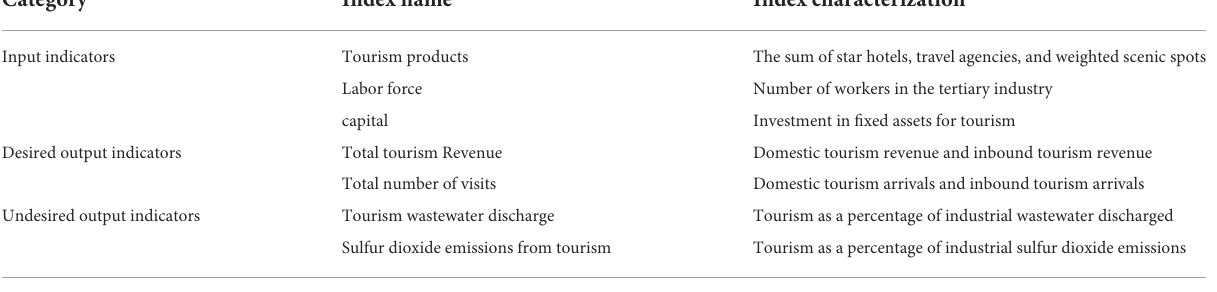
TABLE 1 The tourism eco-efficiency measurement index system of Inner Mongolia.